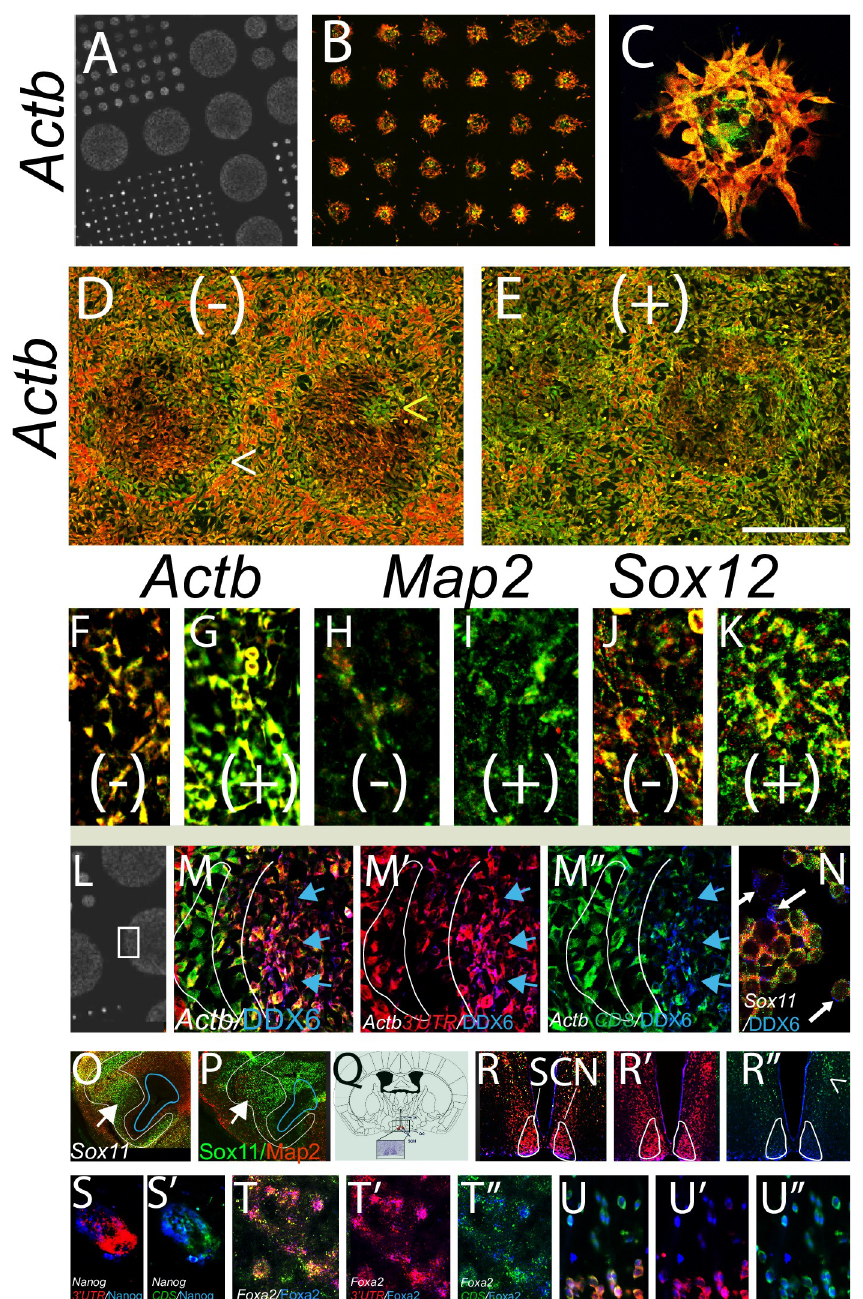
Fig 4. 3’UTR/CDS ratios change with cell state. (A) Photo of Cytoo r chip with circles 800 to 80 um arranged across chip. (B,C) In 80 um circles, 3T3 cells consistently show high Actb CDS in center cells and high 3’UTR in perimeter cells (technical replicates n > 30–50 circles/chip, biological replicates n = 2). In highly confluent cultures cells grow outside the circle. Under normal conditions (D) all cells show very high 3’UTR/CDS except cells at circle border that show high CDS/3’UTR. Stress challenge with 30 min sodium azide (NaZ) (E; + denotes NaZ) causes most cells to express higher Actb CDS compared to 3’UTR (D,E are matched photos). Mini-islands of cells that express the opposite ratio from the majority can be seen, suggesting that the 3’UTR/CDS ratio is due to the state of the cell, not to a hybridization artifact of the chip (Fig 4D; yellow carrot). For three different genes, all increase their 3’UTR/CDS ratio after stress, (F,G) Actb , (H,I) Map2 , (J,K) Sox12 (n = 10 technical replicates, 2 biological replicates). (L-N) Localization of P-body phase marker DDX6 in relation to 3’UTR/CDS. (L) region of Cytoo r chip shown in M-M”. DDX6 is only found in cells with Actb 3’UTR (M’; Actb 3’UTR red, DDX6 blue), not with cells that express primarily CDS (M”;